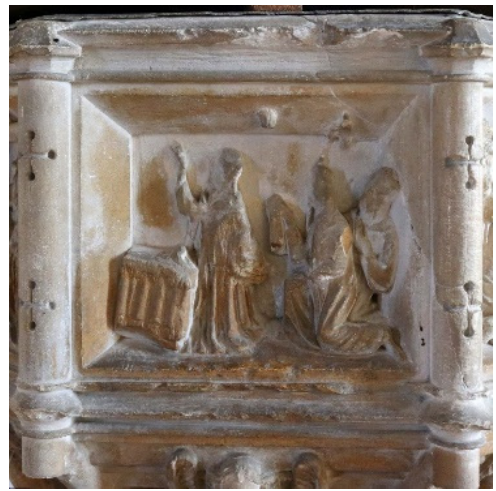
Figure 15. Eucharist. Source: Bob Mitchell.